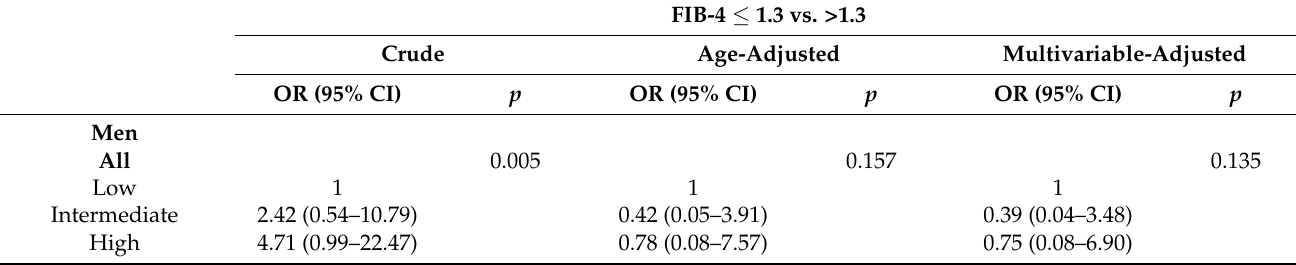
Table 4. Relationship between the risk of having OSA and advanced fibrosis assessed by FIB-4 in NAFLD